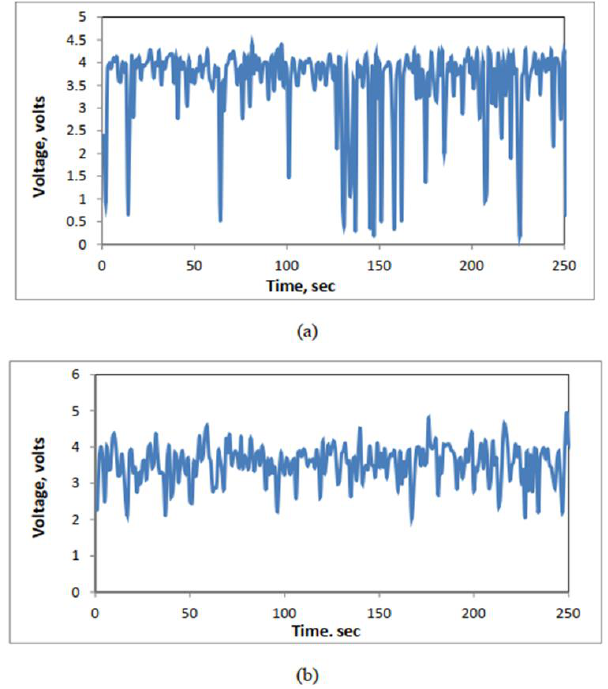
Figure 14. Optical probe signal for matching conditions ( a ) Case 2 in 0.14 m inner dimeter bed and ( b ) Case 1 in 0.44 m inner dimeter fluidized beds at axial height (H/D = 1.7) and radial location (r/R = 0.5).